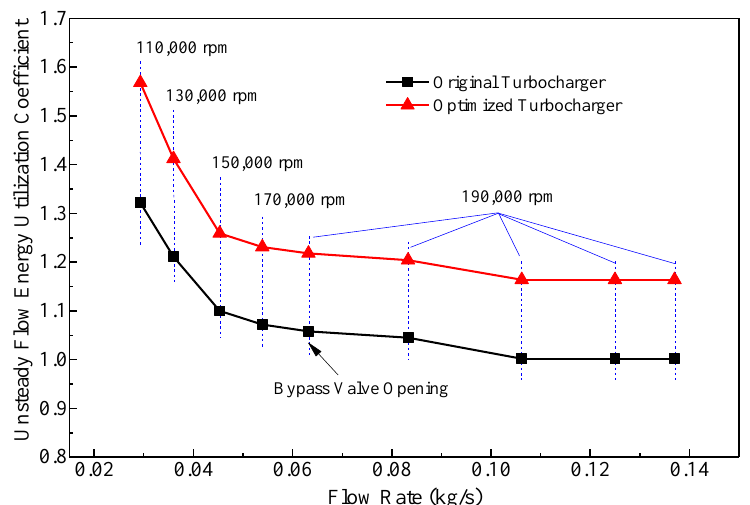
Figure 15. Comparison of turbocharger unsteady flow energy utilization coefficients on internal joint operating curves.